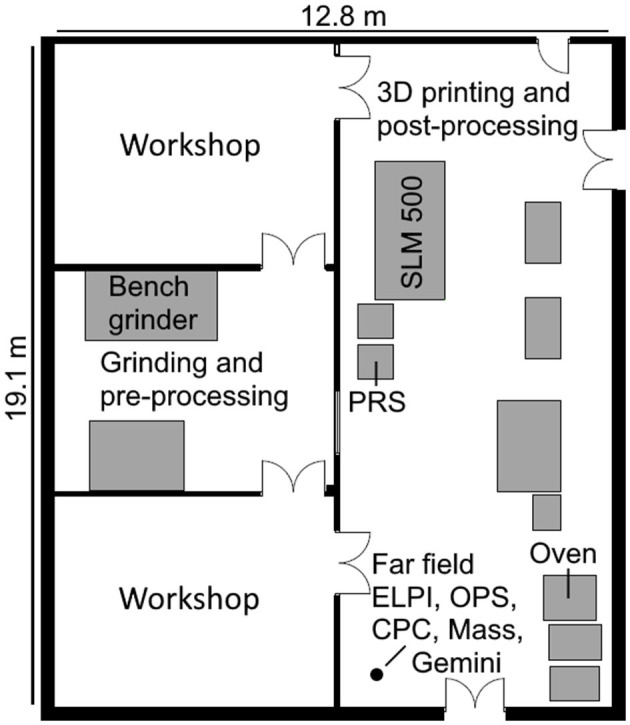
Layout of the working environment. Locations of machines used during processes as well as the stationary FF measurement position are marked. The figure was made to scale according to blueprints of the facility.